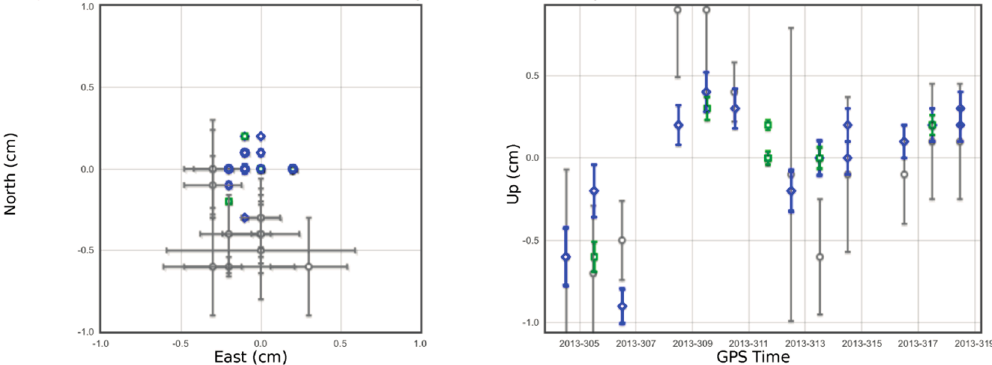
Figure 4. OPUS-Projects processing results for station EAST; horizontal (left); and vertical (right).